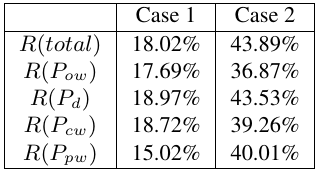
Table 1: Percentage of correct predictions for different test cases. four scenarios show the correctness values for each prediction ( R = correctpredictions/totalpredictions ) factor individu- ally. In each of these scenarios an increase of about 20-25% is recognizable.